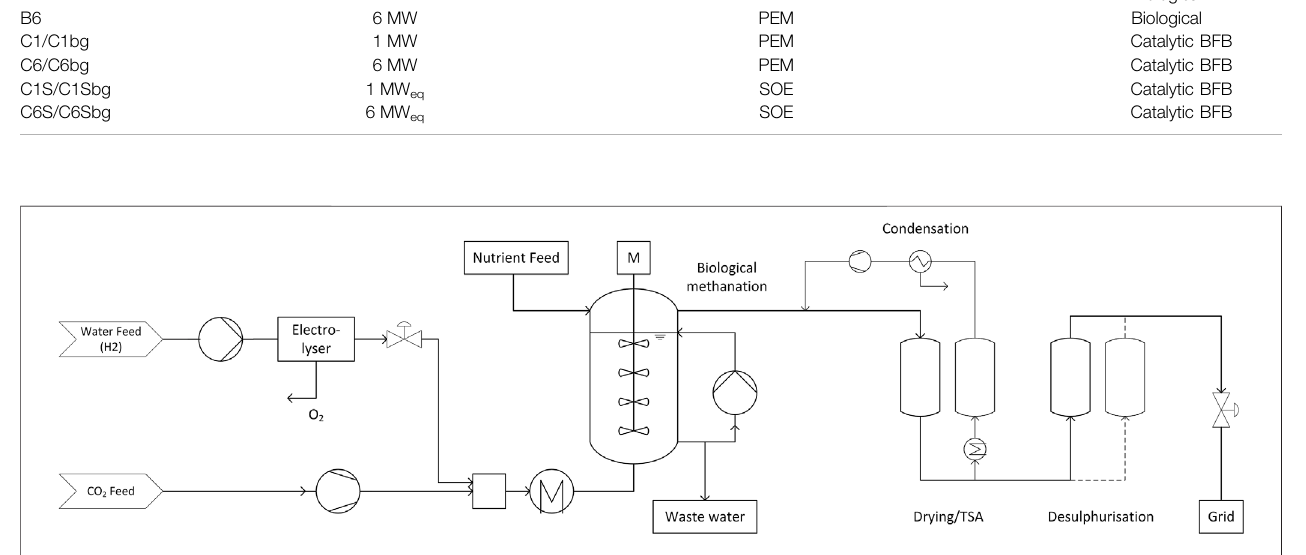
FIGURE 1 | Process chain for the biological methanation of CO 2 .